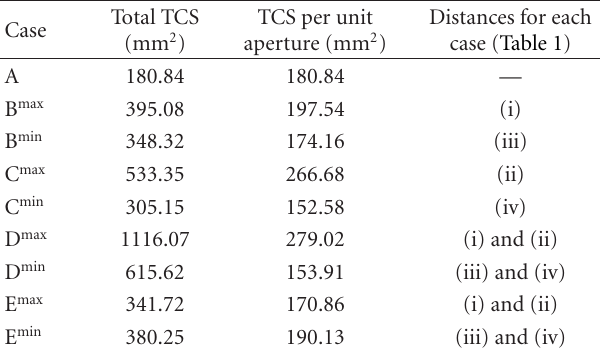
Table 2: Total TCS and TCS per unit aperture (at resonant frequency of 11.02